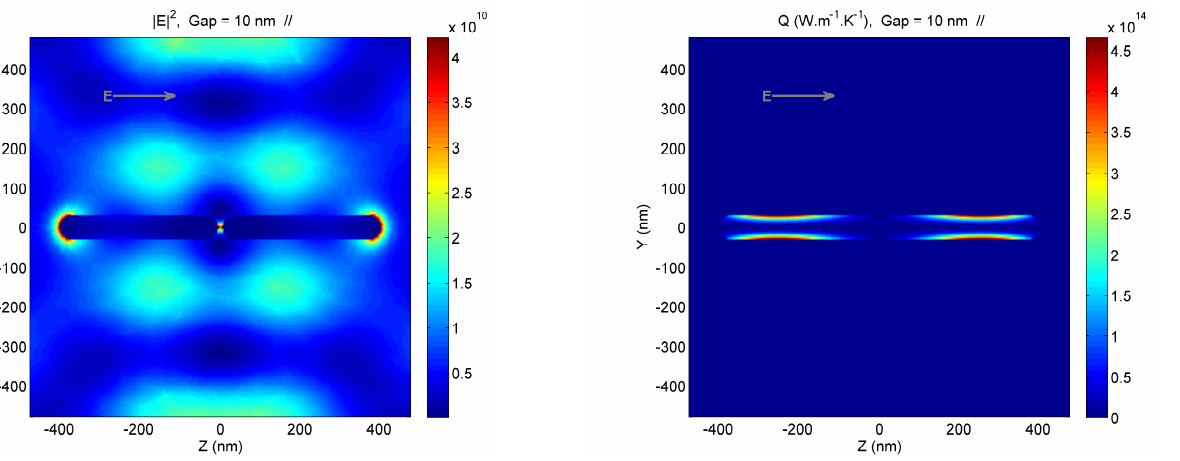
Figure 2: Density of heat source for the stationary heat equation, induced by illumination at 632 . 8 nm : a gaus- sian beam of diameter 25 µm , with power P = 30 mW.